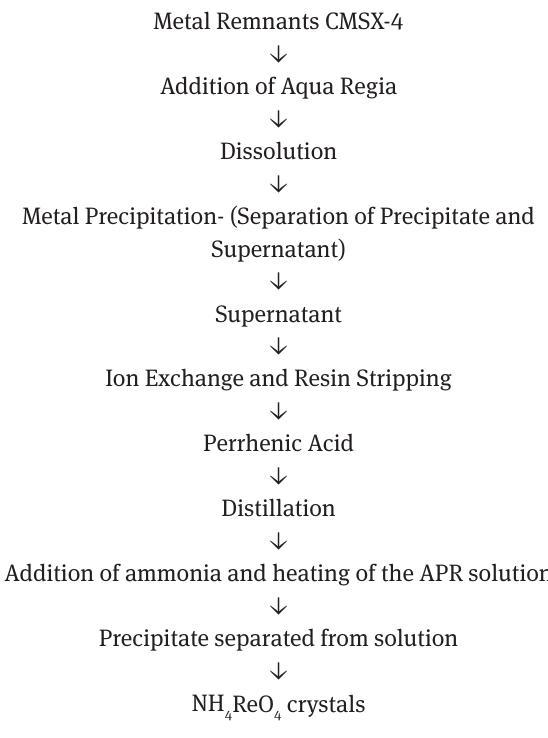
Scheme 1: Flow diagram for the production of Ammonium Perrhenate from CMSX-4